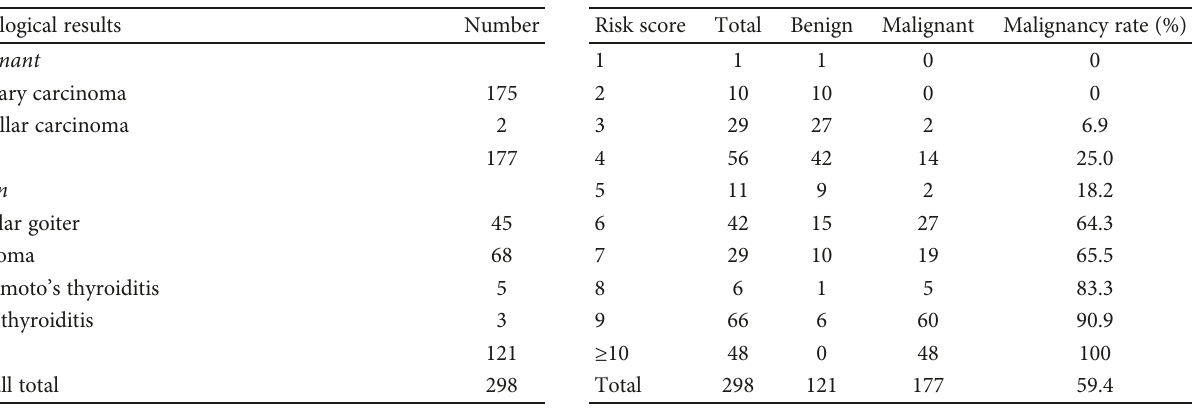
Table 1: Pathological distribution of 298 thyroid nodules.